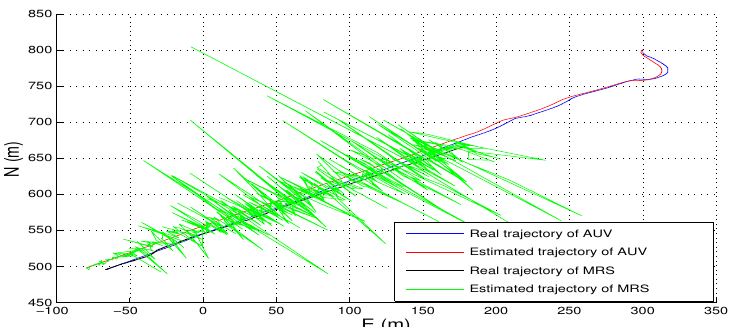
Figure 16. Trajectories of AUV- II and Mobile docking station(M-DS) recorded by IMU in AUV- II homing to